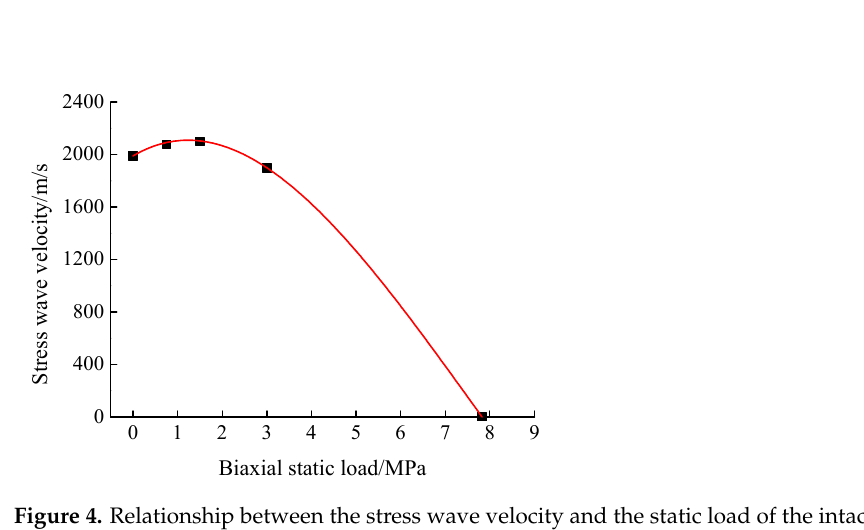
Figure 4. Relationship between the stress wave velocity and the static load of the intact rock. ate. The maximum wave velocity v 0 was defined as the wave velocity of the undamaged rock, so the initial damage variable D 0 of the rock can be defined by the following equation, when the value of D 0 is 0 and 1, respectively, indicating that the rocks are in an undamaged and fully damaged stage.